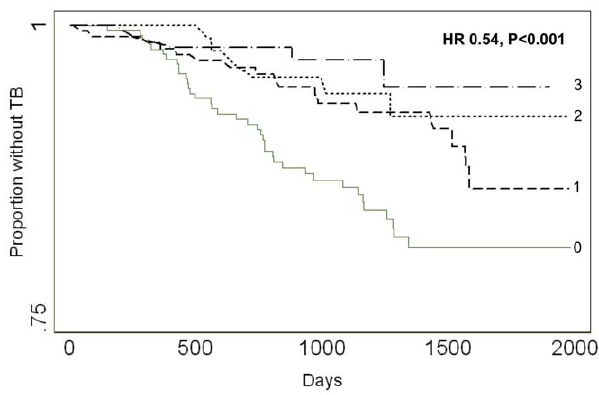
Figure 3. Survival without HIV-associated tuberculosis (TB) according to number of baseline interferon gamma (IFN- c ) responses detected against mycobacterial preparations. The hazard of HIV-associated TB fell 46% with each increment in the number of detectable baseline IFN- c responses against mycobacterial prepara- tions. HR, hazard ratio; TB,